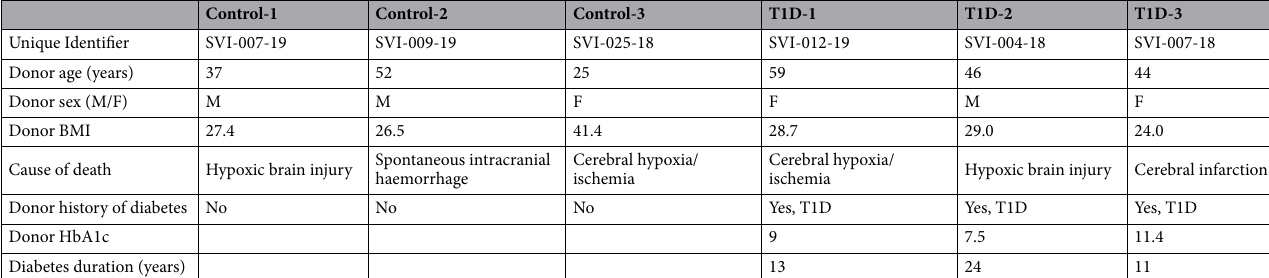
Table 1. Information for donor material used in immunofluorescence studies.